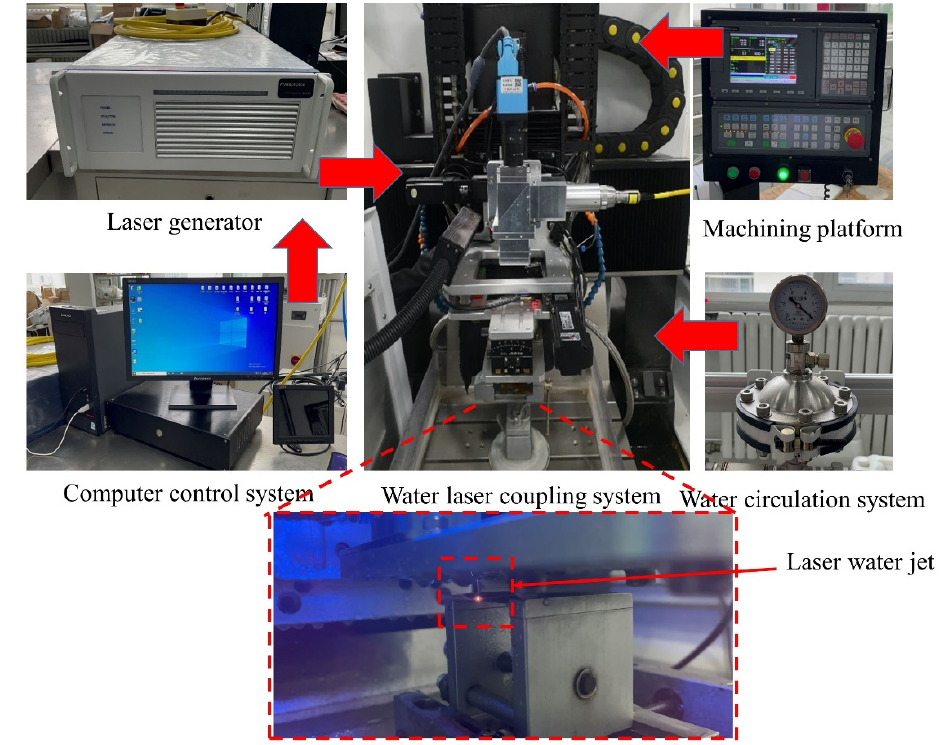
Figure 1. Water-jet-guided laser processing equipment.